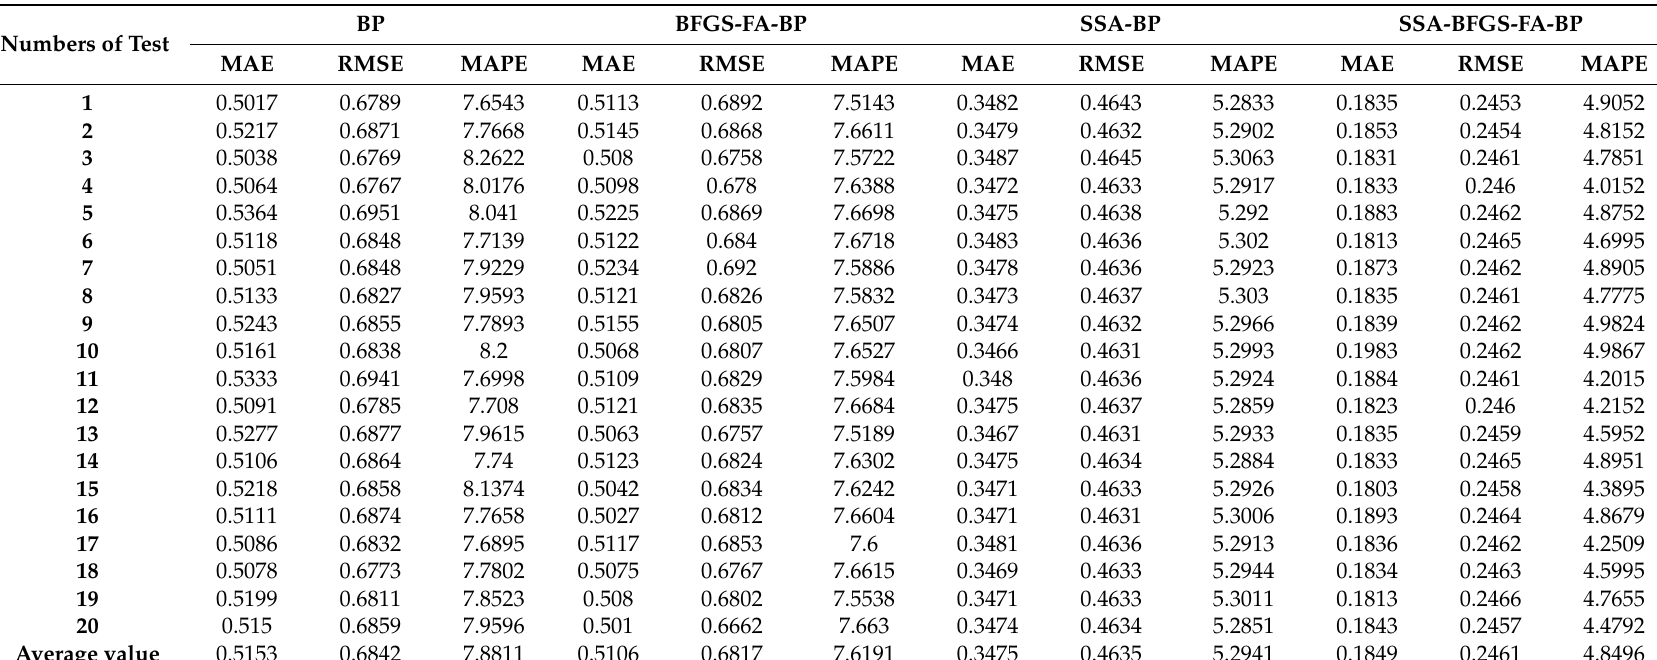
Table 7. MAE, RMSE, and MAPE of site 1 for each forecasting